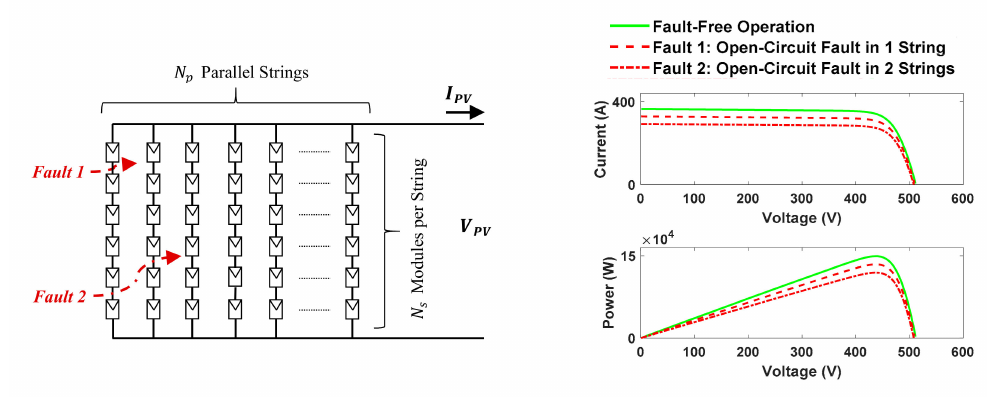
Figure 3. PV array configuration for open-circuit faults at the string level (measured under standard test conditions